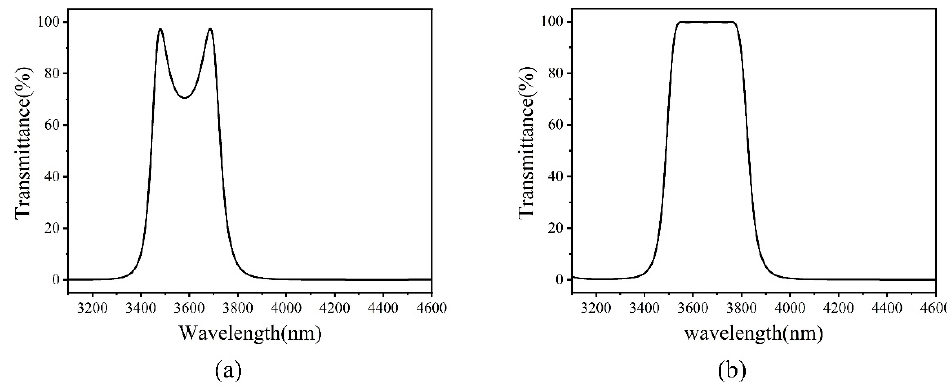
Figure 3. ( a ) Calculated transmittance of bandpass filter for the region 3.55–3.75 µm with the primary structure. The substrate is double-polished silicon (n = 3.5); H = germanium (n = 4.0), L = zinc sulfide (n = 2.35) and the incident medium is air (n = 1.0). ( b ) Calculated transmittance of bandpass filter for the region 3.55–3.75 µm with the optimized structure.